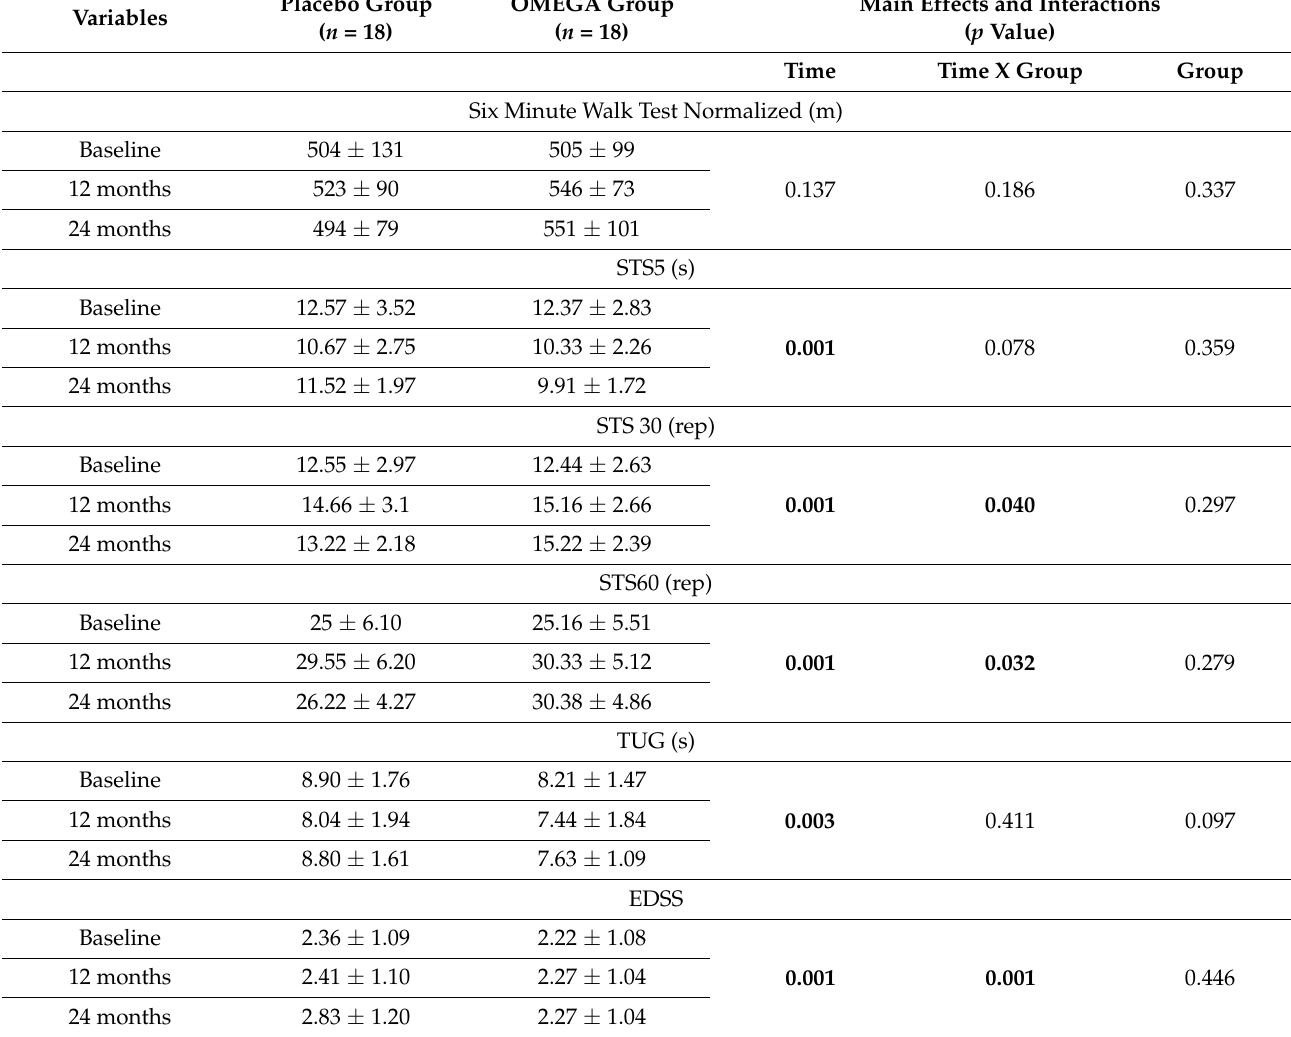
Table 4. Functional capacity and disability score in both groups for all three time-points excluding the dropouts.